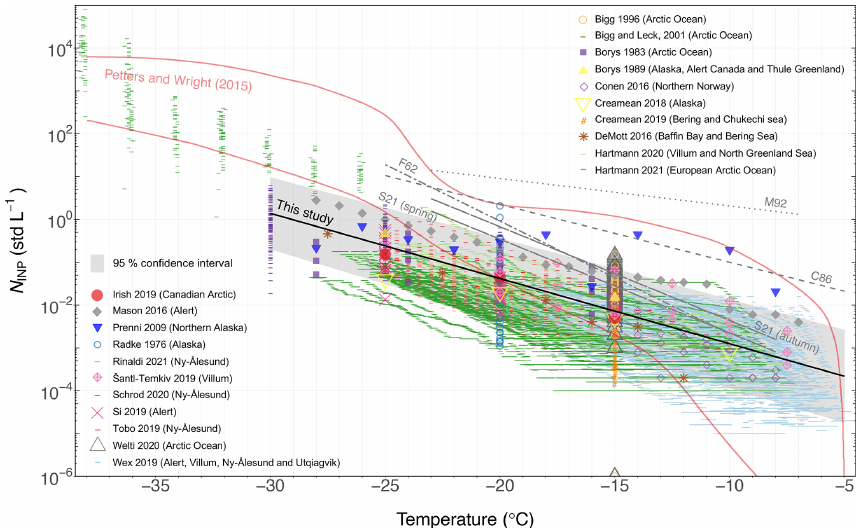
Figure 8. Comparison of Arctic INP concentration measurements in different studies. The INP parameterization developed from this study is presented as a solid black line, with the gray-shaded area representing the log-normal INP concentration distribution within the 95% confidence intervals. The area between the two red lines is a compilation of INP concentrations determined from precipitation samples from the midlatitudes (Petters and Wright, 2015). The dotted (M92), dashed (C86), dotted–dashed (F62), and long-dashed (S21) lines indicate the INP parameterization from Meyers et al. (1992), Cooper (1986), Fletcher (1962), and Schneider et al. (2021), respectively. The S21 (autumn) and S21 (spring) for Schneider et al. (2021) parameterization represent INP concentrations predicted during our autumn 2019 and spring 2020 campaign, given the average ambient temperature of − 4 . 1 and − 13 . 1 ◦ C,